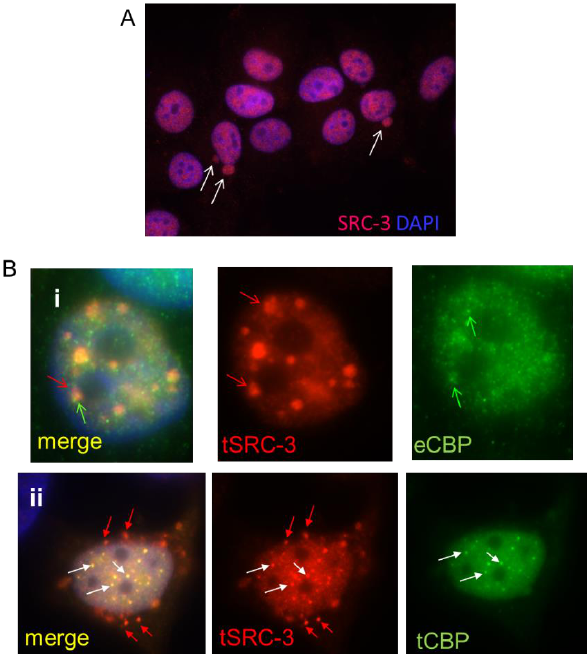
Figure 1. SRC-3 undergoes nuclear extrusion dependent on association with CBP. ( A ) MCF-7 cells cultured as described in Methods were subjected to IF for SRC-3. DNA was visualized with DAPI. Arrows indicate nuclear SRC-3 protrusions (63 × magnification). ( B ) MCF-7 cells transfected with SRC-3 (tSRC-3) in the absence (endogenous only- eCBP)(panel i) or presence of cotransfected (tCBP) CBP (panel ii). In panel (i) Z-stack images show SRC-3 aggregates overlapping with diffuse CBP (red arrows). CBP not associated with SRC-3 is indicated by the green arrow. In panel (ii) some aggregates merge as CBP and SRC-3 foci (white arrows), while others near the nuclear periphery contain only SRC-3 (red arrows) (100 × magnification).